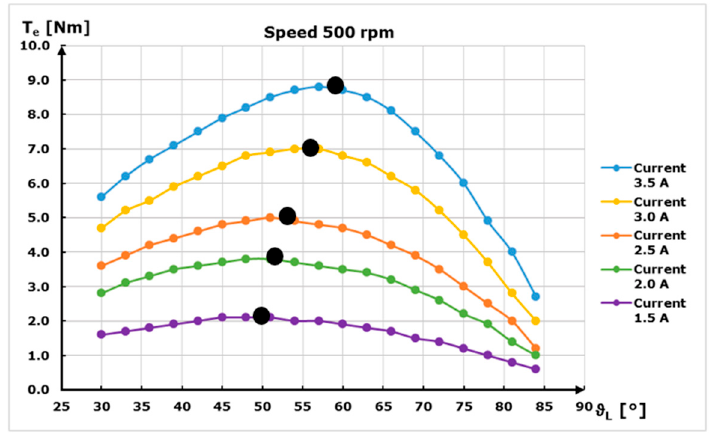
Figure 3. Torque versus load angle at 500 rpm for various phase currents.